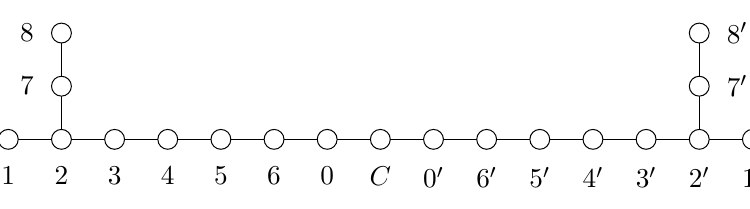
Figure 1 . EDD of the Γ